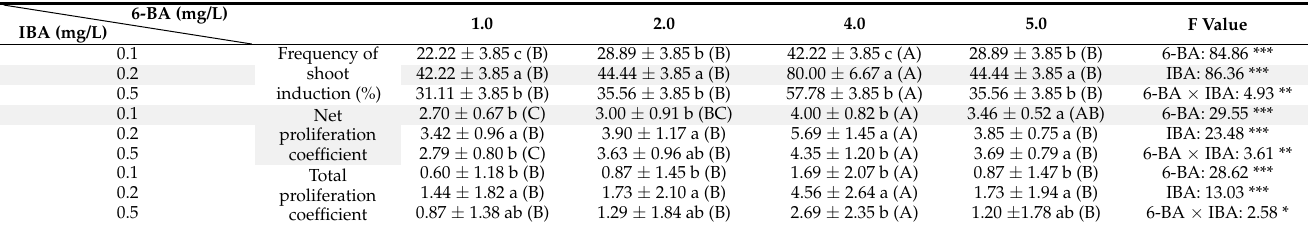
Table 8. Effects of 6-BA and IBA on the frequency of shoot induction and the proliferation coefficient.